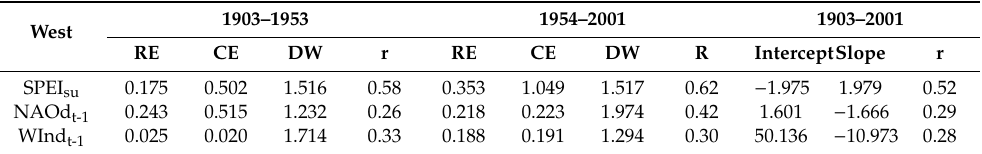
Table 5. Calibration verification statistics for the dendroclimatic reconstructions of climatic variables using tree-ring width indices in the Cedrus atlantica study site for the period of 1903–2001. Climate variables were current summer SPEI 12-month scale (SPEI su ); previous December NAO (NAOd t-1 ); and previous November–December Westerly Index (WInd t-1 ). Statistics’ abbreviations: RE, reduction of error; CE, coefficient of efficiency; and DW, Durbin–Watson